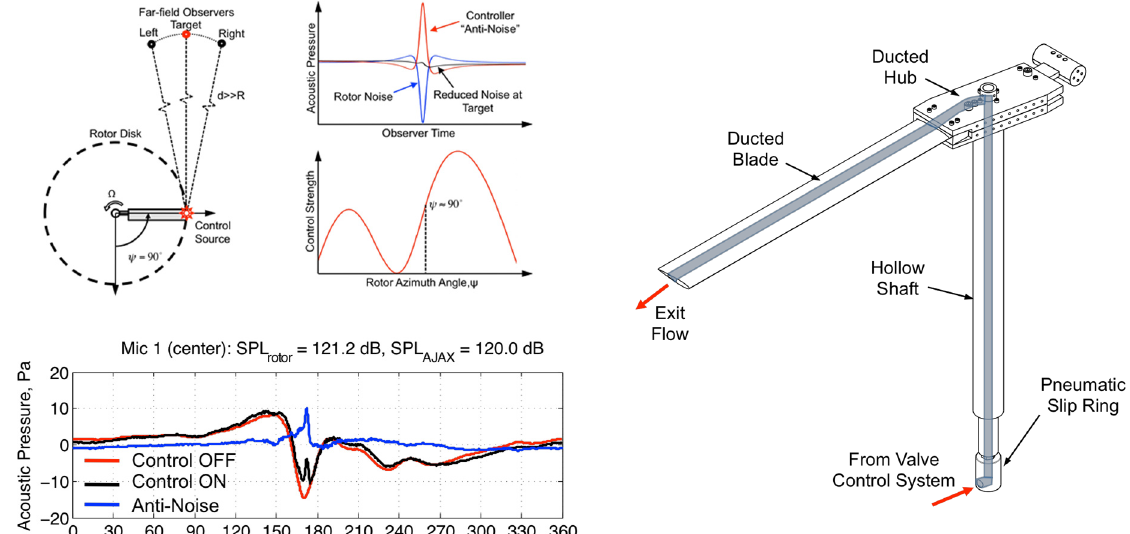
Figure 9. Experimental Setup for tip air blowing [50]. Reprinted with permission from Sargent, D.C. (2014).